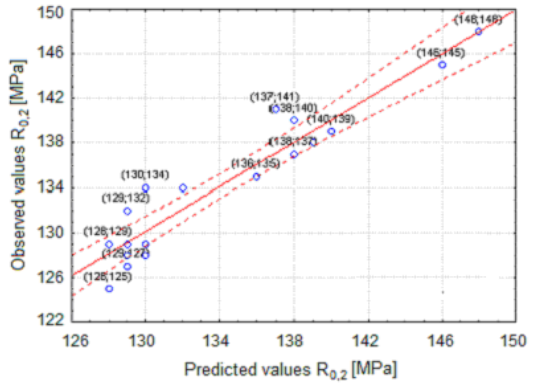
Fig. 6. Diagram of predicted and observed values for the variable HB 0,2